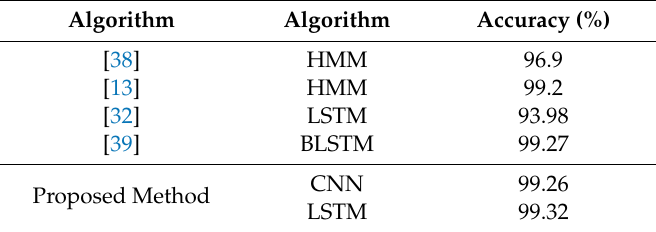
Table 3. The proposed LSTM and CNN model evaluation using the 6DMG